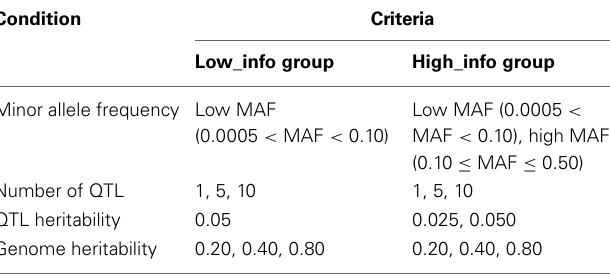
Table 1 | Settings criteria in the simulation study.